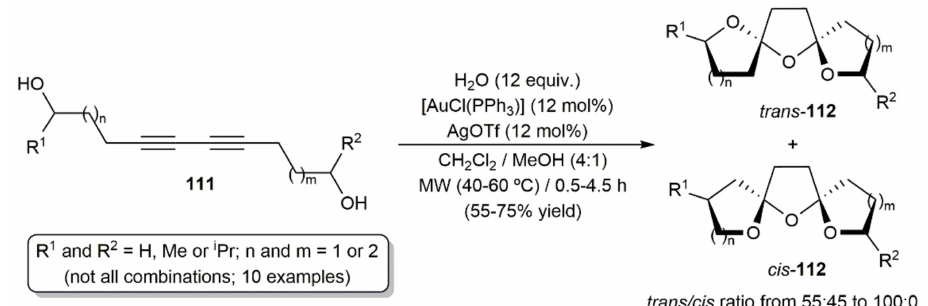
Scheme 62. Gold-catalyzed synthesis of bis-spiroketals from diynediol derivatives. The reaction pathway leading to compounds 112 was elucidated by DFT calculations using 5,7-diyne-1,12-diol as a model [164]. As shown in Scheme 63, the pyranyl enol ether intermediate V is initially generated by a gold-mediated 6- exo-dig cyclization, evolving into the bis-enol ether W by a second 6- exo-dig addition. A subsequent dihydration of W leads to X , which converts into the final bis-spiroketal products by dehydrative ring closure. In complete agreement with the trans/cis ratio experimentally observed (69:31), the computations indicated a slightly lower energy for the trans isomer (1.08 Kcal/mol).